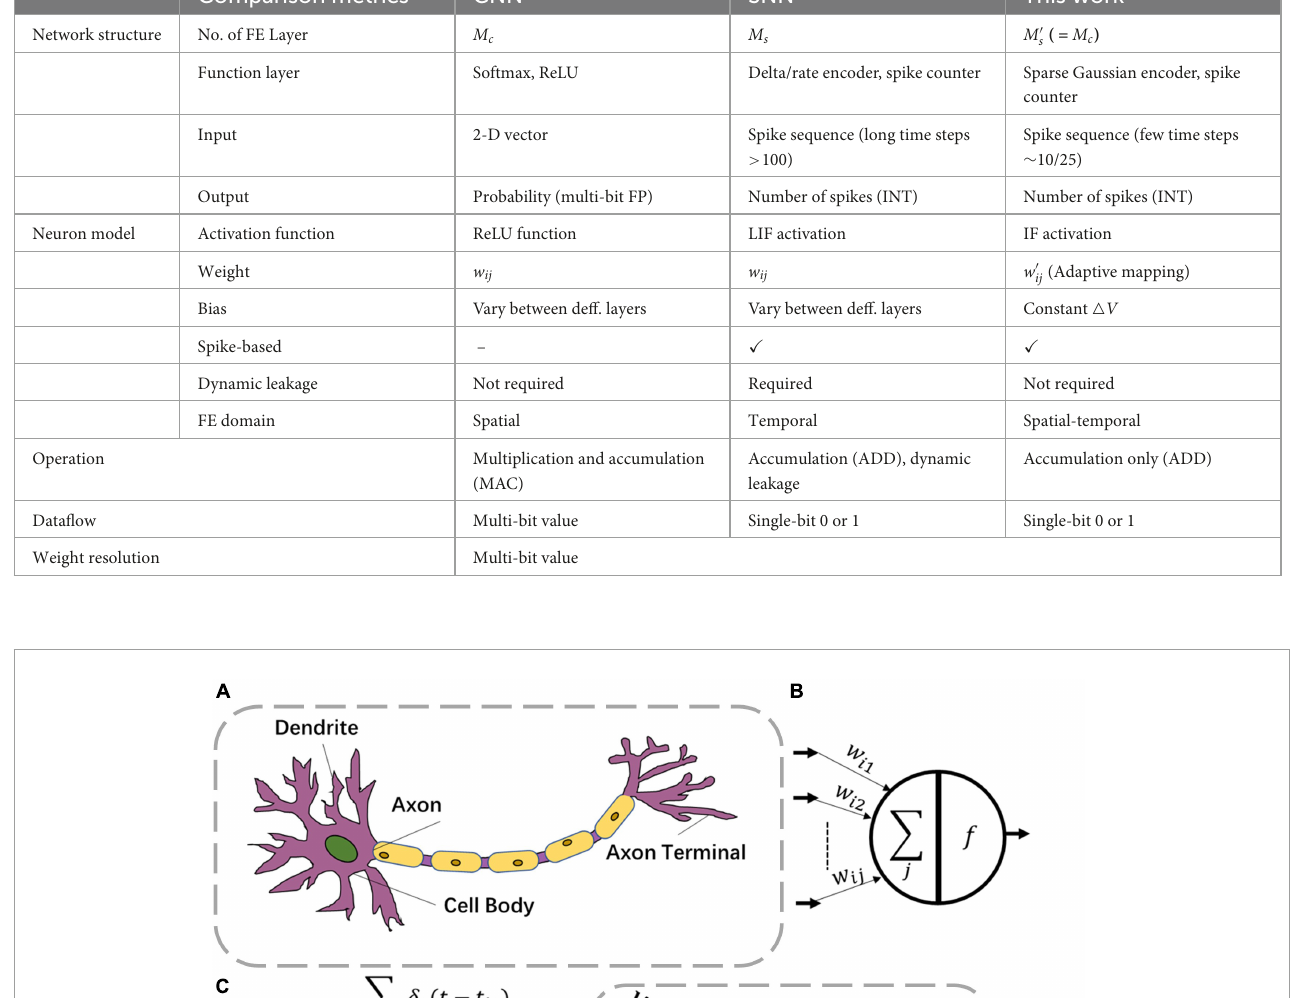
TABLE 1 Overall comparison between convolutional neural network (CNN), spiking neural network (SNN), and this work. Comparison metrics